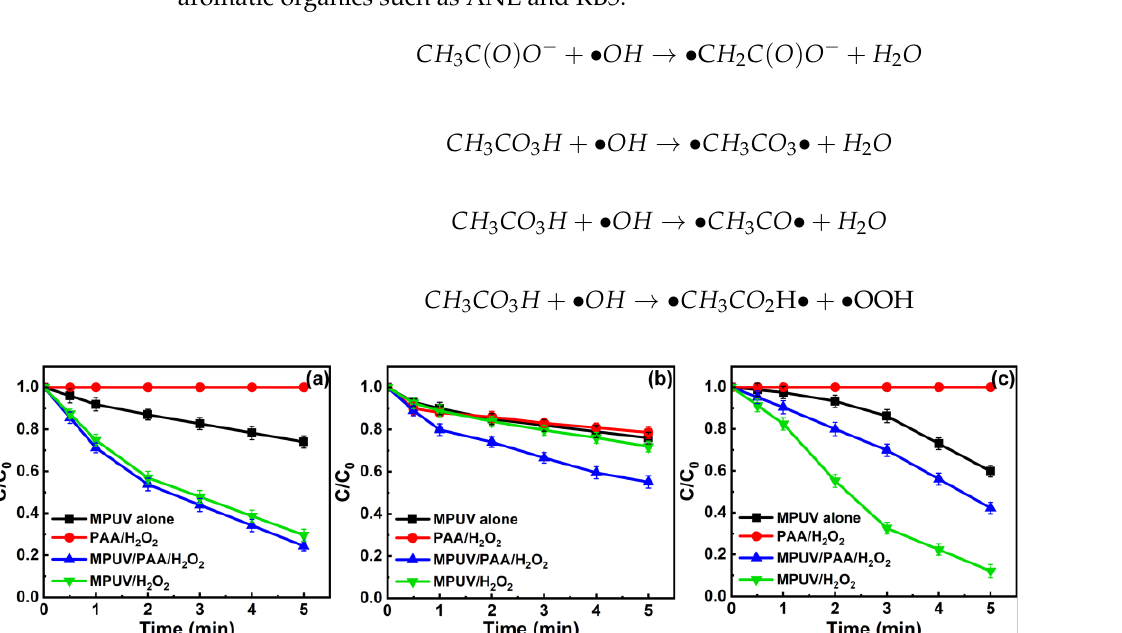
Figure 1. Effects of PAA/H 2 O 2 , MPUV alone, MPUV/PAA/H 2 O 2 , and MPUV/H 2 O 2 systems on the removal of ( a ) RB5, ( b ) ANL, and ( c ) PVA. Conditions: [PAA] 0 = 15 mg/L, [H 2 O 2 ] 0 = 3 mg/L, [Contaminant] 0 = 10 mg/L, UV fluence rate = 5 mW/cm 2 , UV exposure time = 5 min, pH 7.5, with 10 M phosphate buffer, T = 25 ± 1 °C.